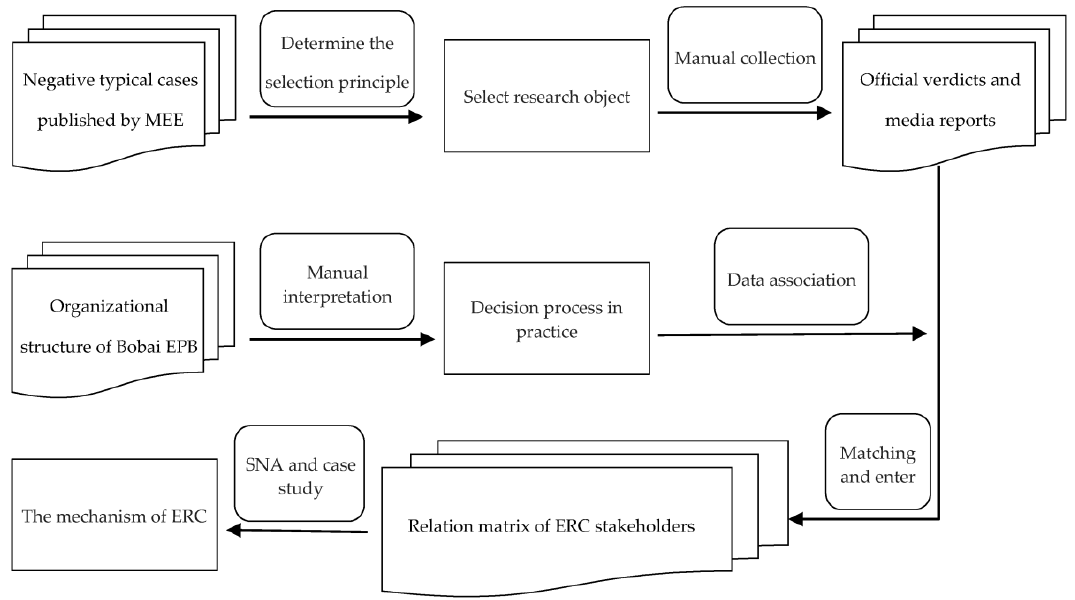
Figure 2. The data collection and analysis process.